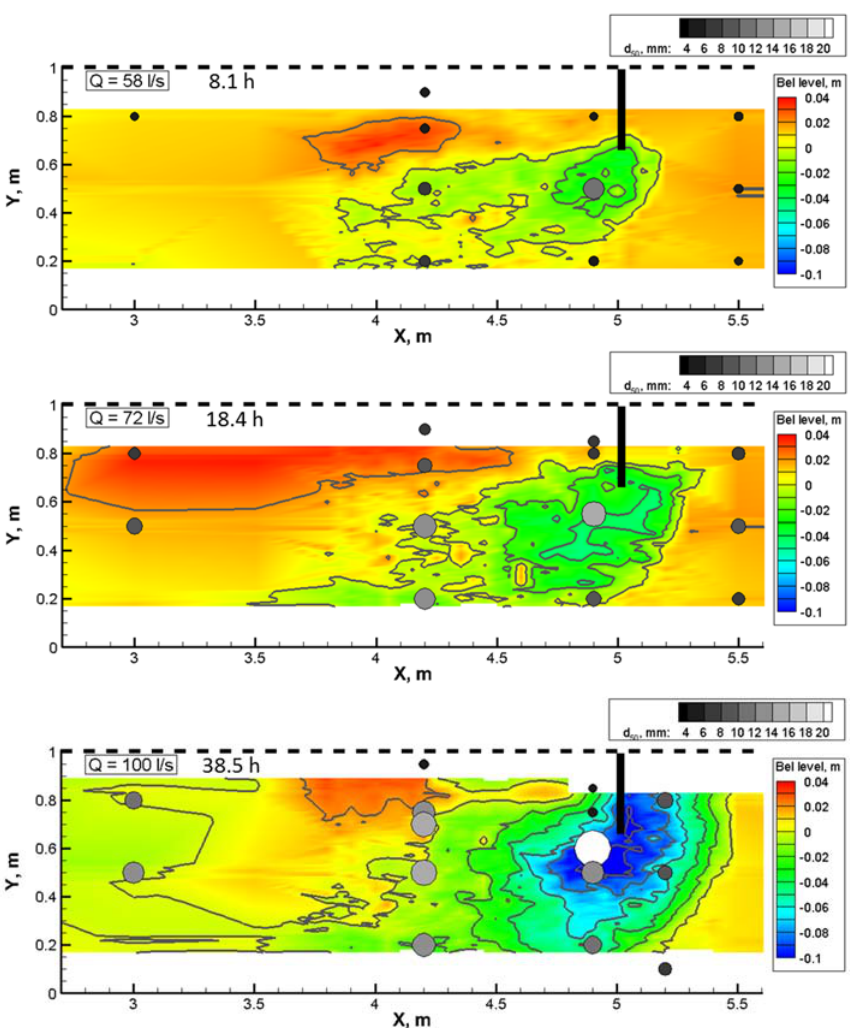
Figure 3. Contour plots: bed changes distribution after each experiment. Circles: local VbW d 50 (volume ‐ by ‐ weight) values of the bed surface (size and tone indicate size).